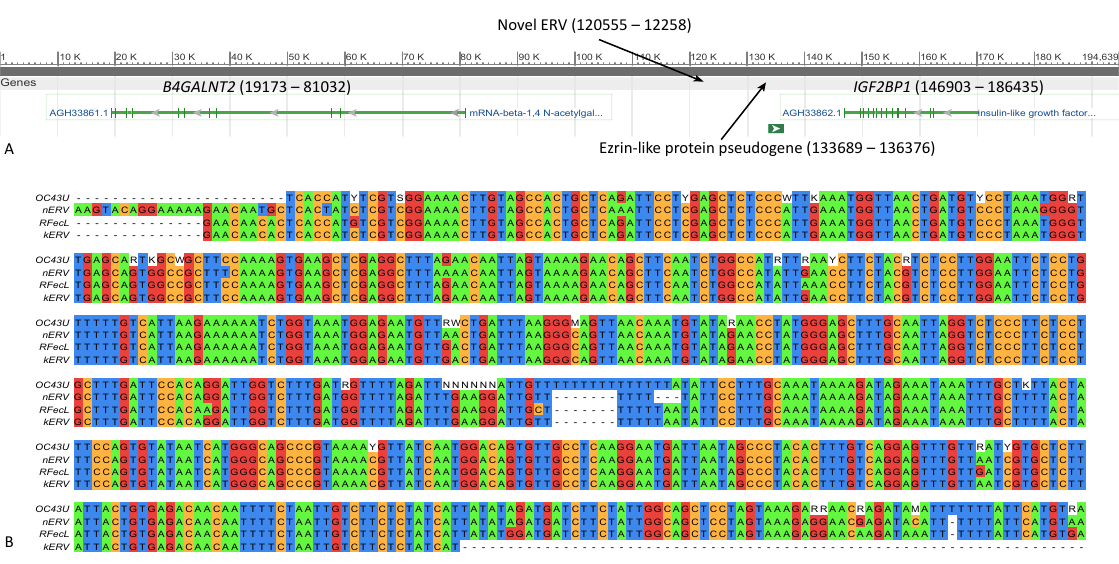
Fig. 1. Multiple sequence alignment (partial) of the novel endogenous retrovirus gene. (A) The novel ERV identified in this study belongs to FecL locus and is located between B4GALNT2 and ezrin-like protein pseudogene. (B) The multiple sequence alignment was prepared using Clustal Omega (Madeira et al. 2019) based on the novel ERV (nERV, ENSOARG00000009959), ovine endogenous- virus beta-2 pro/pol region, partial sequence (kERV, AY193894.1), Ovis canadensis canadensis isolate 43U chromosome 17 sequence (OC43U, CP011902.1) and the reverse complement of reduced FecL locus (RFecL, KC352617). The bases are colored based on the nucleotide coloring scheme in Jalview (Waterhouse et al.